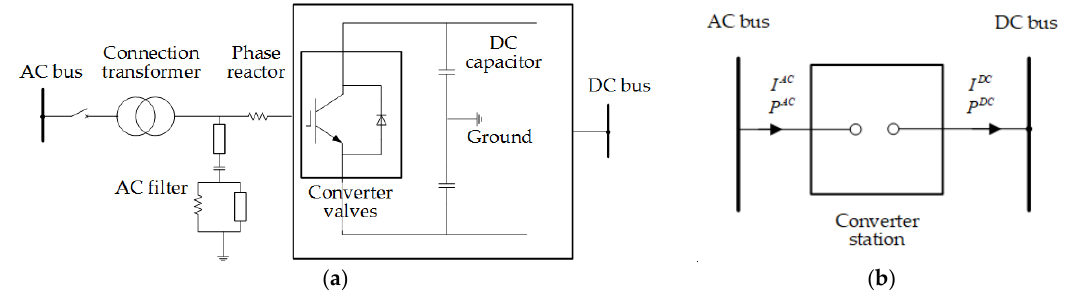
Figure 2. Schematic diagram of a converter station based on VSC. ( a ) Original schematic diagram; and ( b ) equivalent schematic diagram.